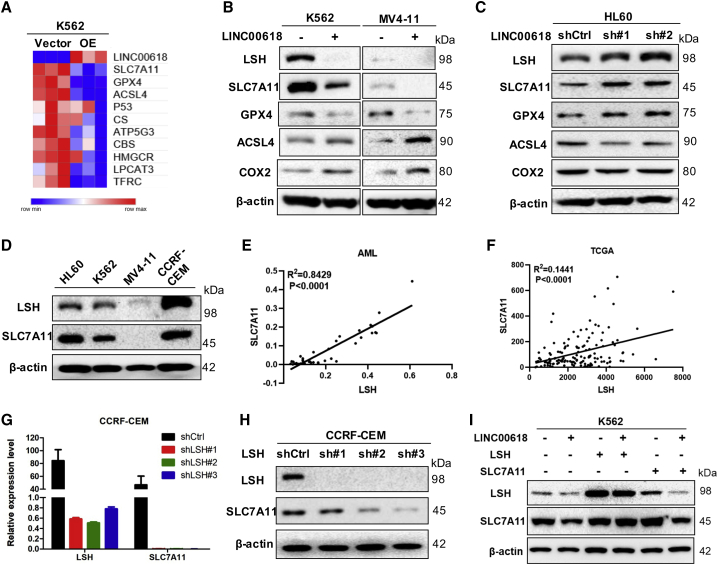
SLC7A11 Is Regulated by LINC00618 through LSH(A) qPCR-based heatmap indicating the changes of ferroptosis-related genes in K562 cells stably overexpressing LINC00618. (B) Western blot analyses of LSH, SLC7A11, and ferroptosis-related proteins in K562 and MV4-11 cells stably overexpressing LINC00618. (C) Western blot analyses of LSH, SLC7A11, and ferroptosis-related proteins in HL60 cells after the knockdown of LINC00618. (D) Protein expression level of LSH and SLC7A11 in four leukemia cells. (E) The correlation between LSH and SLC7A11 mRNA level was measured in 38 AML tissues. (F) The correlation between LSH and SLC7A11 mRNA level was analyzed in TCGA-LAML samples. (G) qPCR analyses of SLC7A11 in CCRF-CEM cells after the knockdown of LSH. (H) Western blot analyses of SLC7A11 in CCRF-CEM cells after the knockdown of LSH. (I) Western blot analyses of LSH and SLC7A11 in K562 cells stably overexpressing LINC00618 with LSH or SLC7A11 overexpression. Data are shown as the mean ± SEM; n ≥ 3 independent experiments, two-tailed Student’s t test: ns, nonsignificant (p > 0.05), ∗p < 0.05, ∗∗p < 0.01, ∗∗∗p < 0.001.